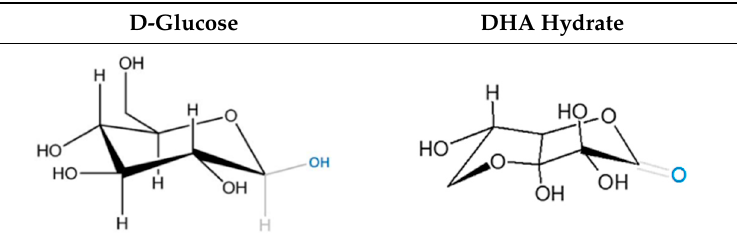
Table 3. Similarities between configurations of D-glucose and dehydroascorbate hydrate structure.